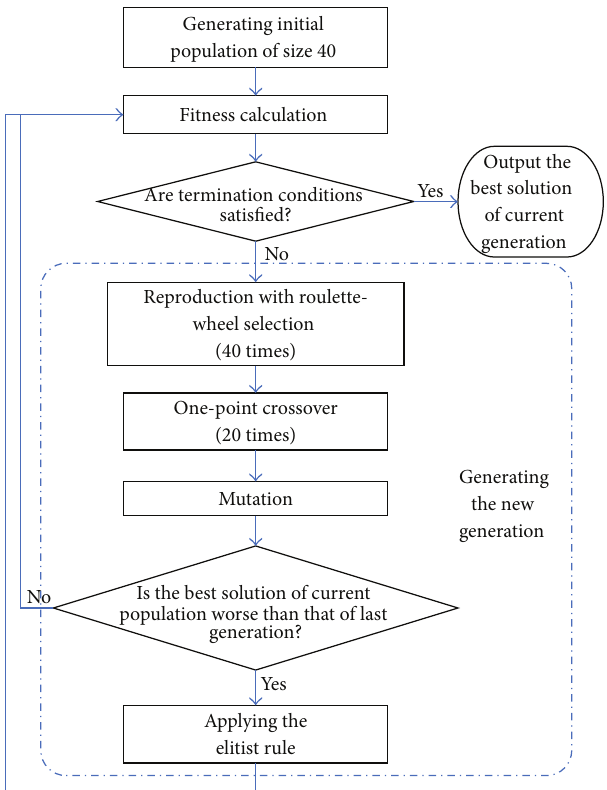
Figure 1: The GA’s flow